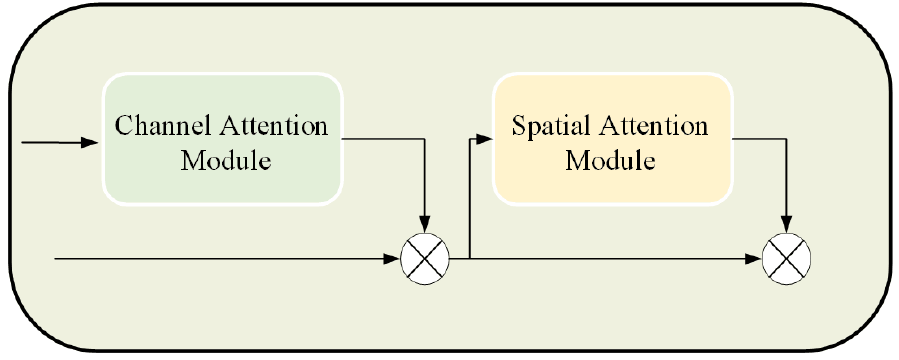
Figure 4. The architecture of the attention mechanism module.